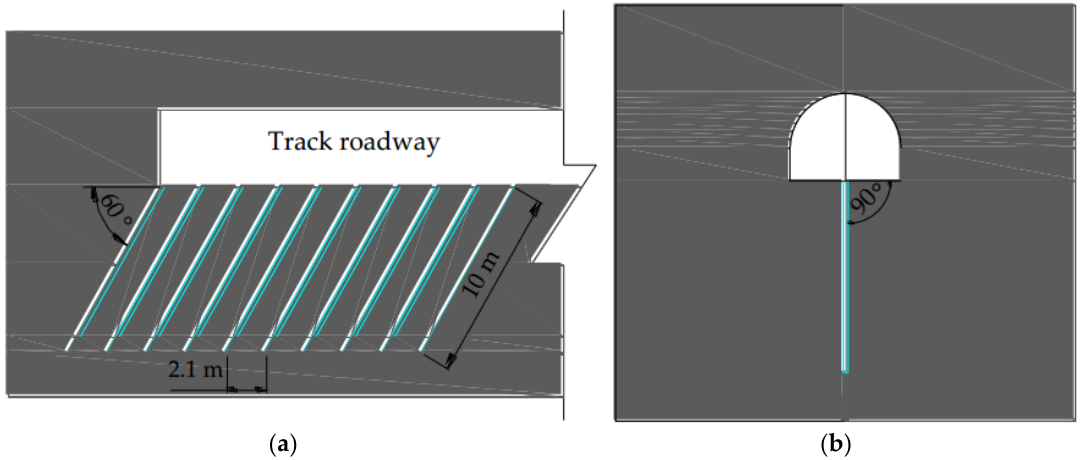
Figure 18. Large-diameter destress boreholes at the heading face and roadway sidewalls in the bottom slice of coal seam: ( a ) Profile along the roadway strike; ( b ) Profile along the roadway tendency. Table 6. Design parameters for large-diameter destress boreholes in the top slice of coal seam, constructed at the heading face and roadway sidewalls.